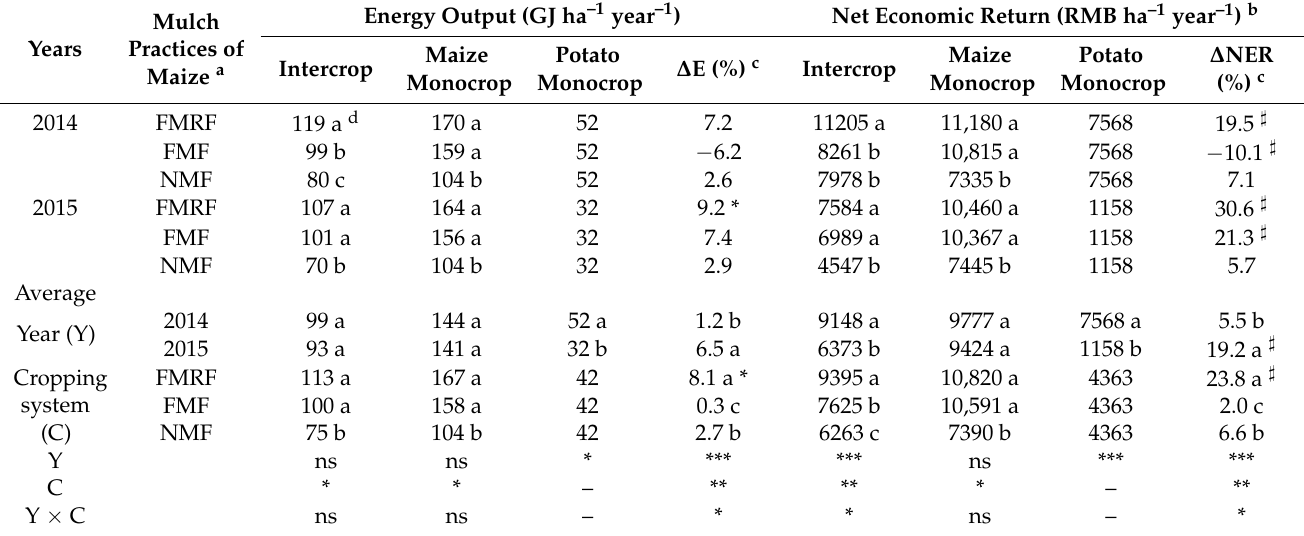
Table 8. Energy output and net economic return of component crops in the intercropping compared with monocrop in